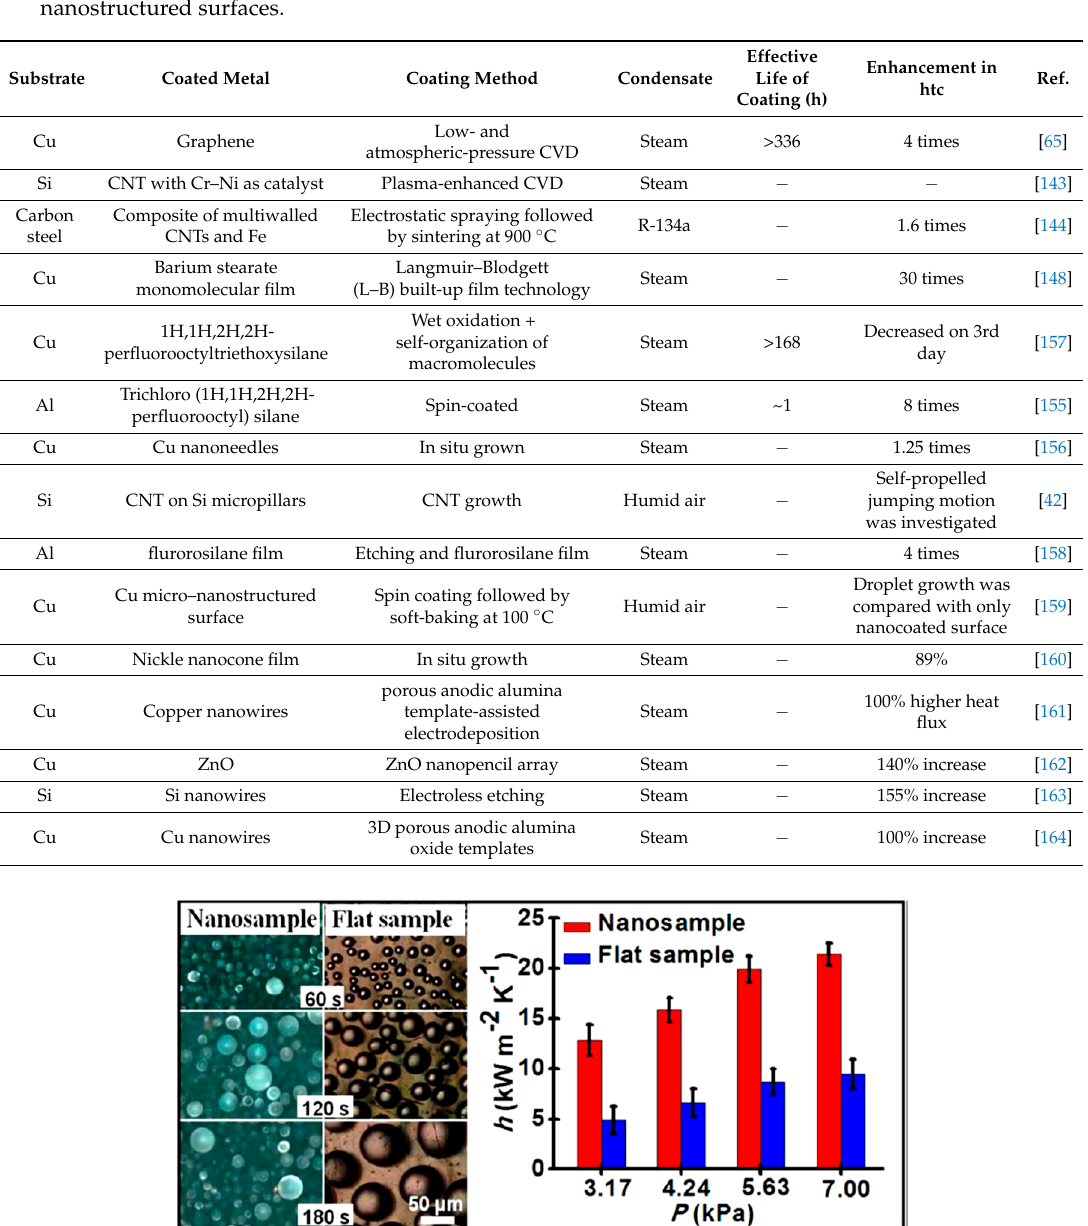
Figure 11. Visual comparison of dropwise condensation and increase in heat transfer coefficient of the flat sample and nanosample coated Cu substrate [156].